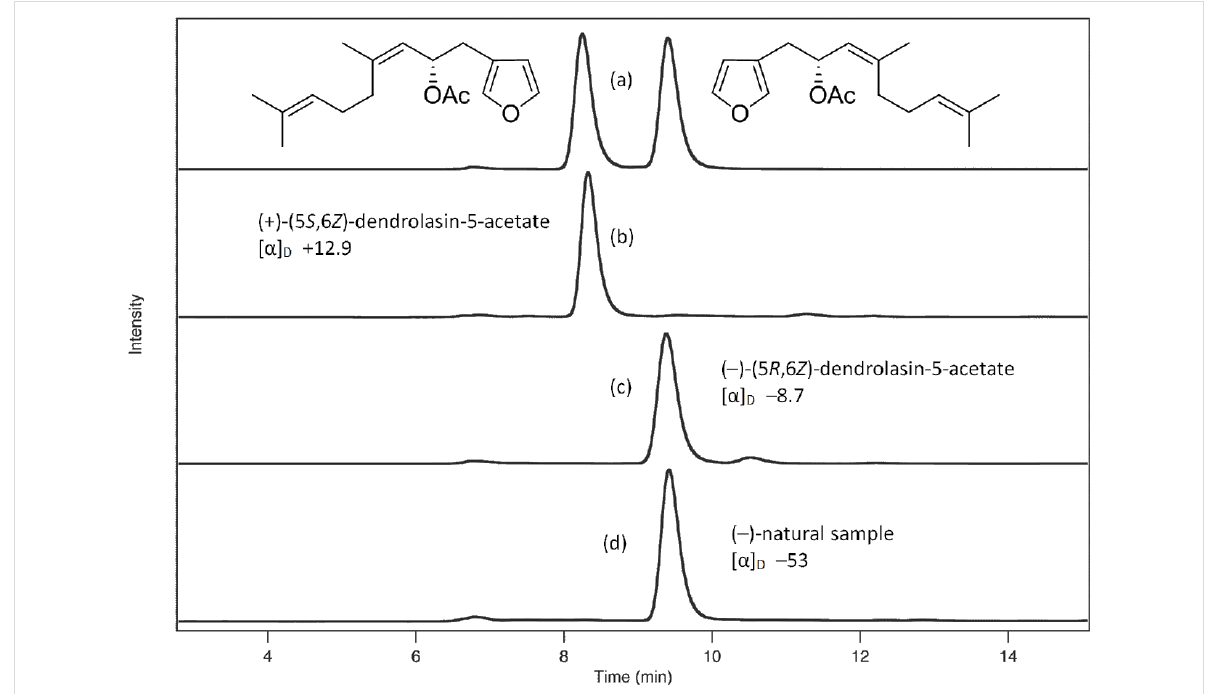
Figure 7: Enantioselective HPLC profiles (5% isopropanol in n -hexane) of 1 : (a) synthetic (±) mixture; (b) synthetic (+)-enantiomer; (c) synthetic ( − )- enantiomer; (d) natural sample from H. jacksoni